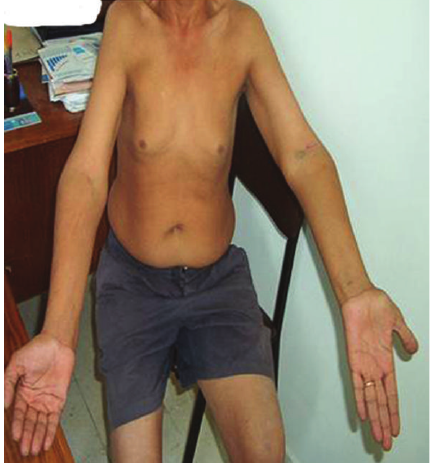
Figure 4: Cubitus varus of both elbows more marked in left.